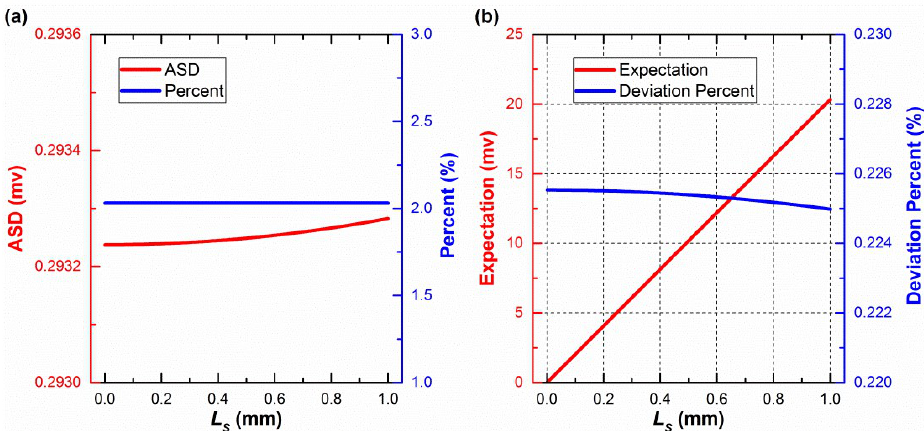
Figure 12. After using the central-symmetry method: ( a ) The influence of L S on ASD and percent; ( b ) the influence of L S on expectation and deviation percent.